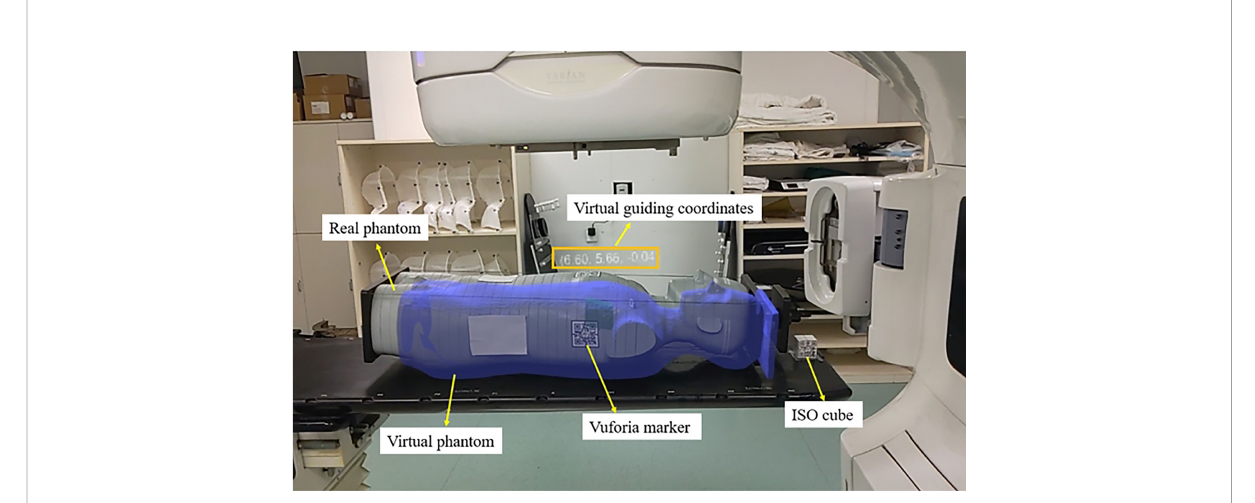
FIGURE 5 The AR scene of the therapist ’ s perspective shows a virtual anthropomorphic phantom in the treatment